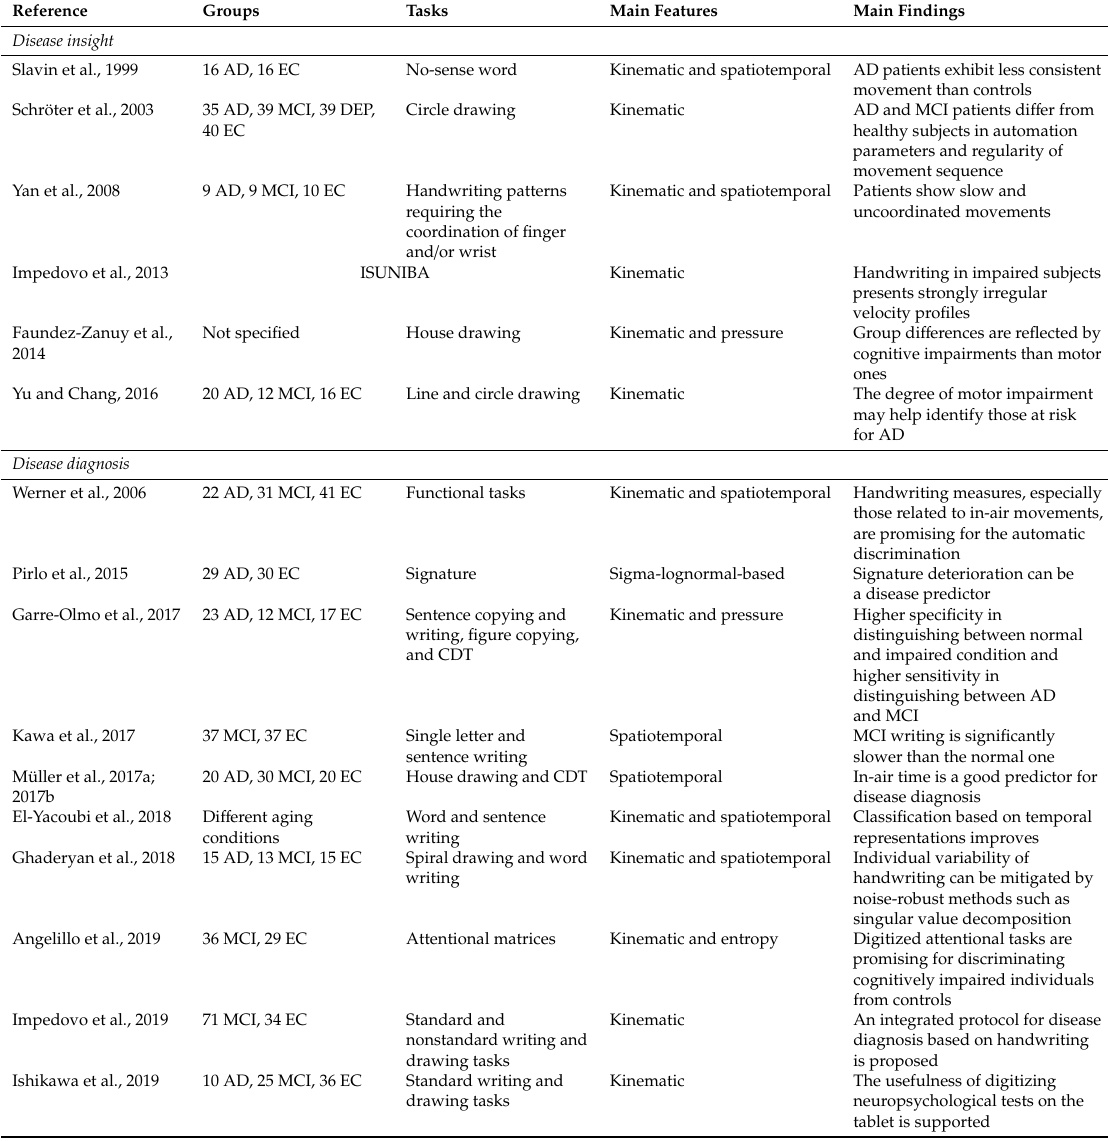
Table 4. Summary of studies on AD (EC = elderly controls; YC = young controls; DEP = depressed